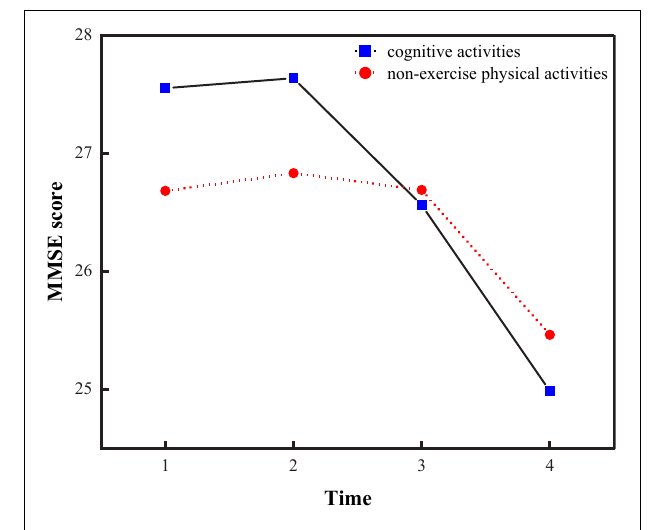
FIGURE 8 | Cognitive ability scores for different types of leisure